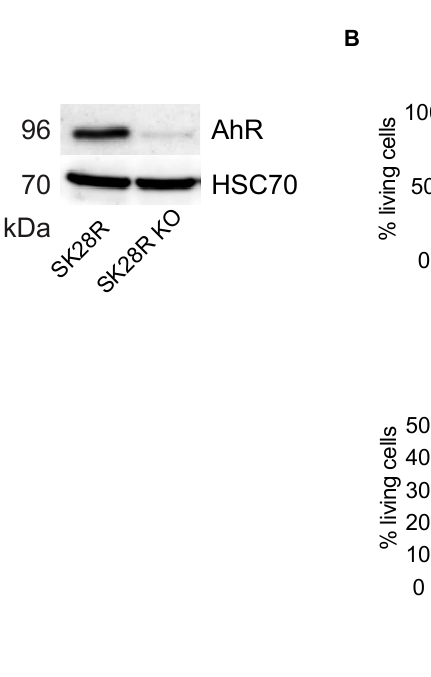
Figure 5. Drug efficiency in SKMel28 melanoma cell lines in the presence or absence of AhR. ( A ) AhR protein levels relative to that of HSC70 were analyzed by western blotting in SKMel28 cells in the presence or not AhR (CRISPR/Cas9). ( B ) SKMel28 and SKMel28 AhR KO cells were treated for 48 h at a dose leading to an approximately 50% reduction in cell viability (IC50). Histograms show the percentage of cell viability ( n = 3) after treatment with ABT-263 (5 μ M), SB505124 (20 μ M), Afatinib (20 μ M), and CHIR − 99021_1241 (20 μ M). Each histogram represents the mean ± s.d.; with unpaired t -tests with Sidak-Bonferroni method ( n = 4–6).